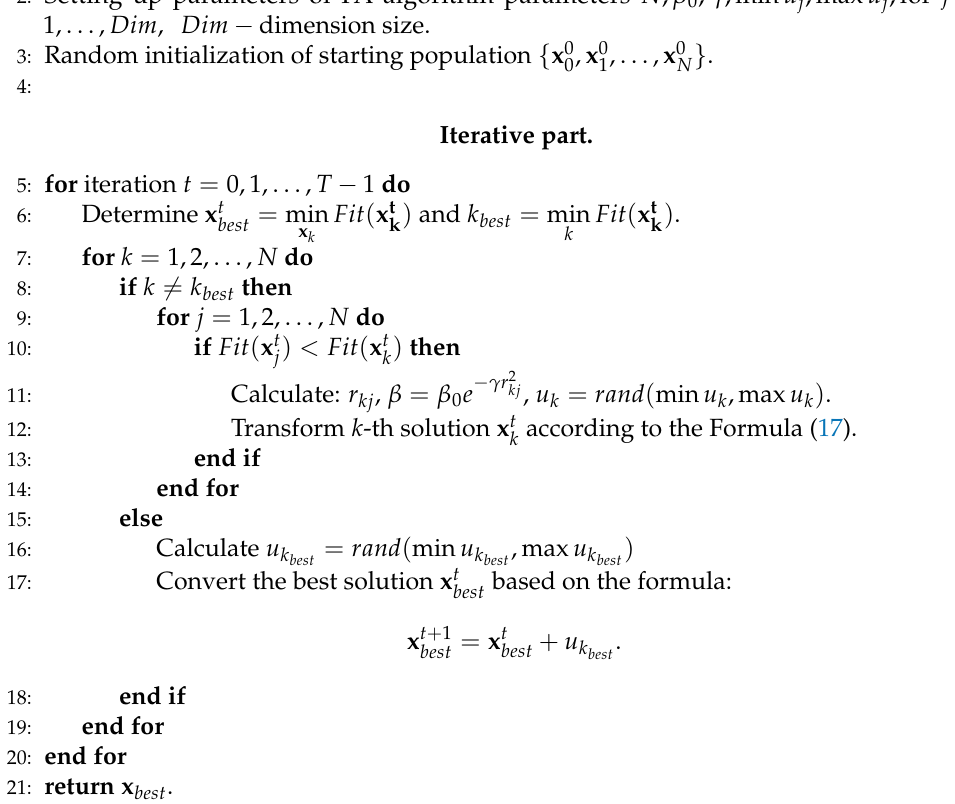
Algorithm 2 Firefly algorithm (FA)